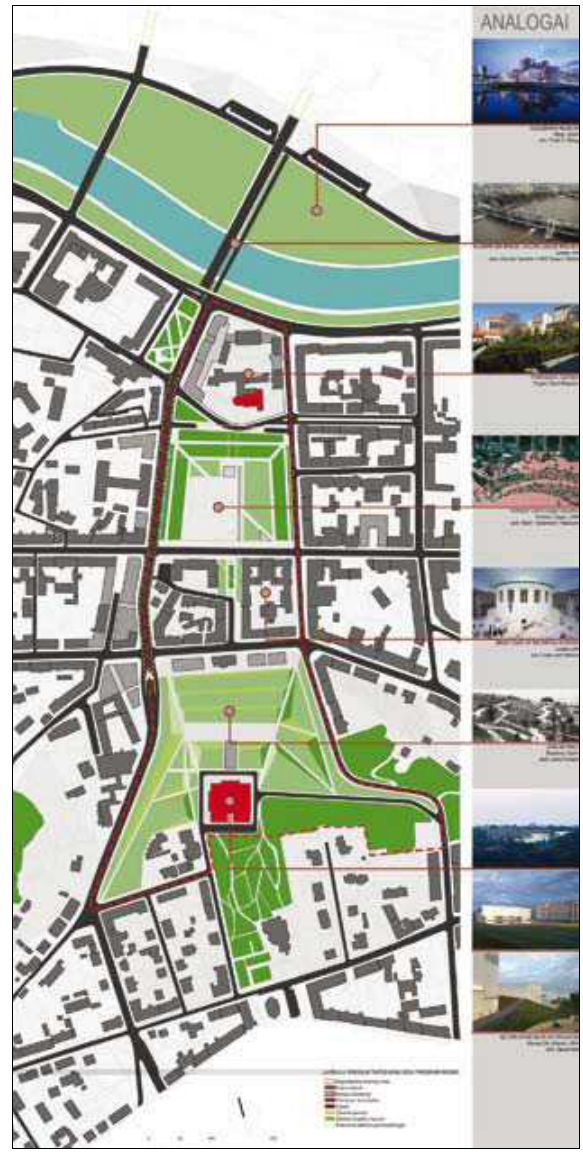
Fig. 13. Urban development program of territories near Lukiškės